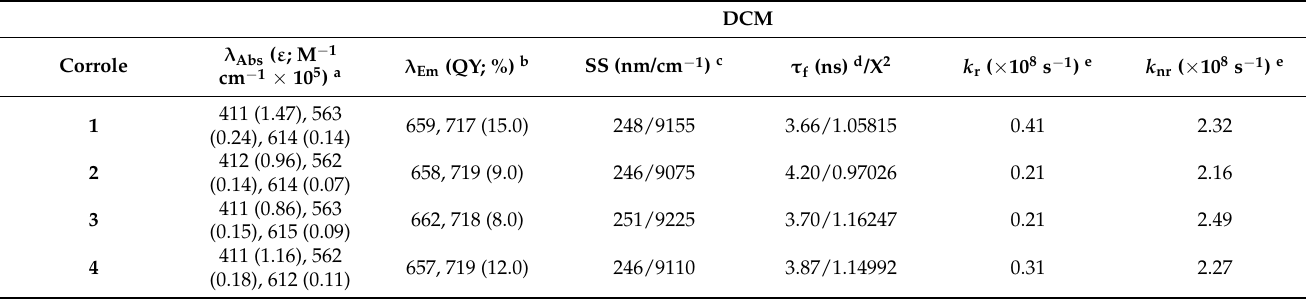
Table 1. Photophysical data of corroles 1 – 4.